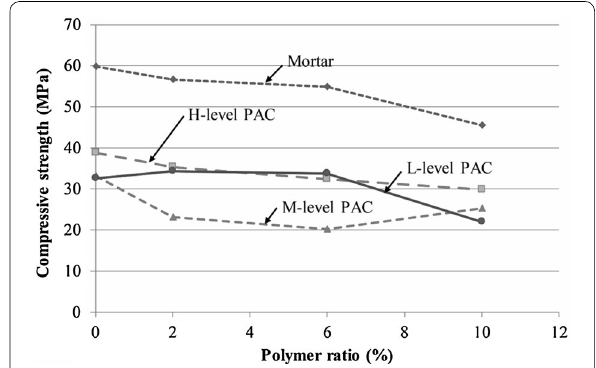
Fig. 16 Compressive strengths of all mortar and concrete samples at 28 days of